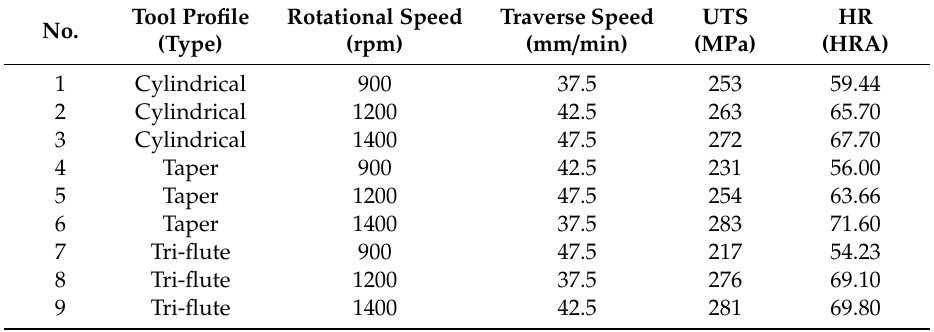
Table 7. Taguchi L 9 orthogonal array parameter setting and experimental results of hardness and tensile